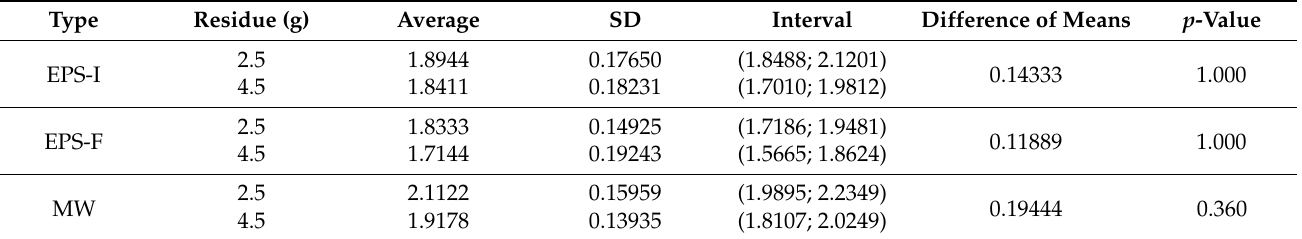
Table 16. Comparison for the absorption by capillarity (kg/mm 2 min 0.5 ) between mortars with incorporation of thermal insulation